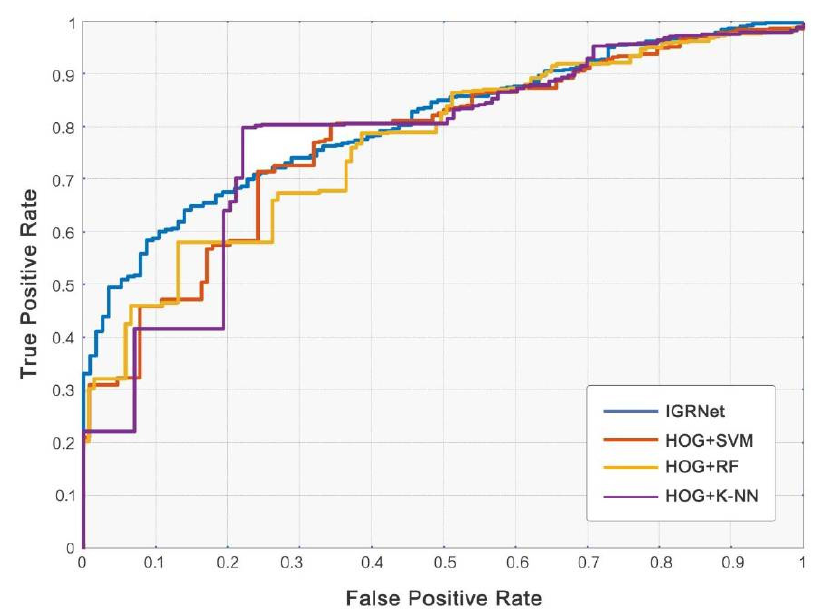
Figure 8. ROC curves of IGRNet and baseline algorithms.